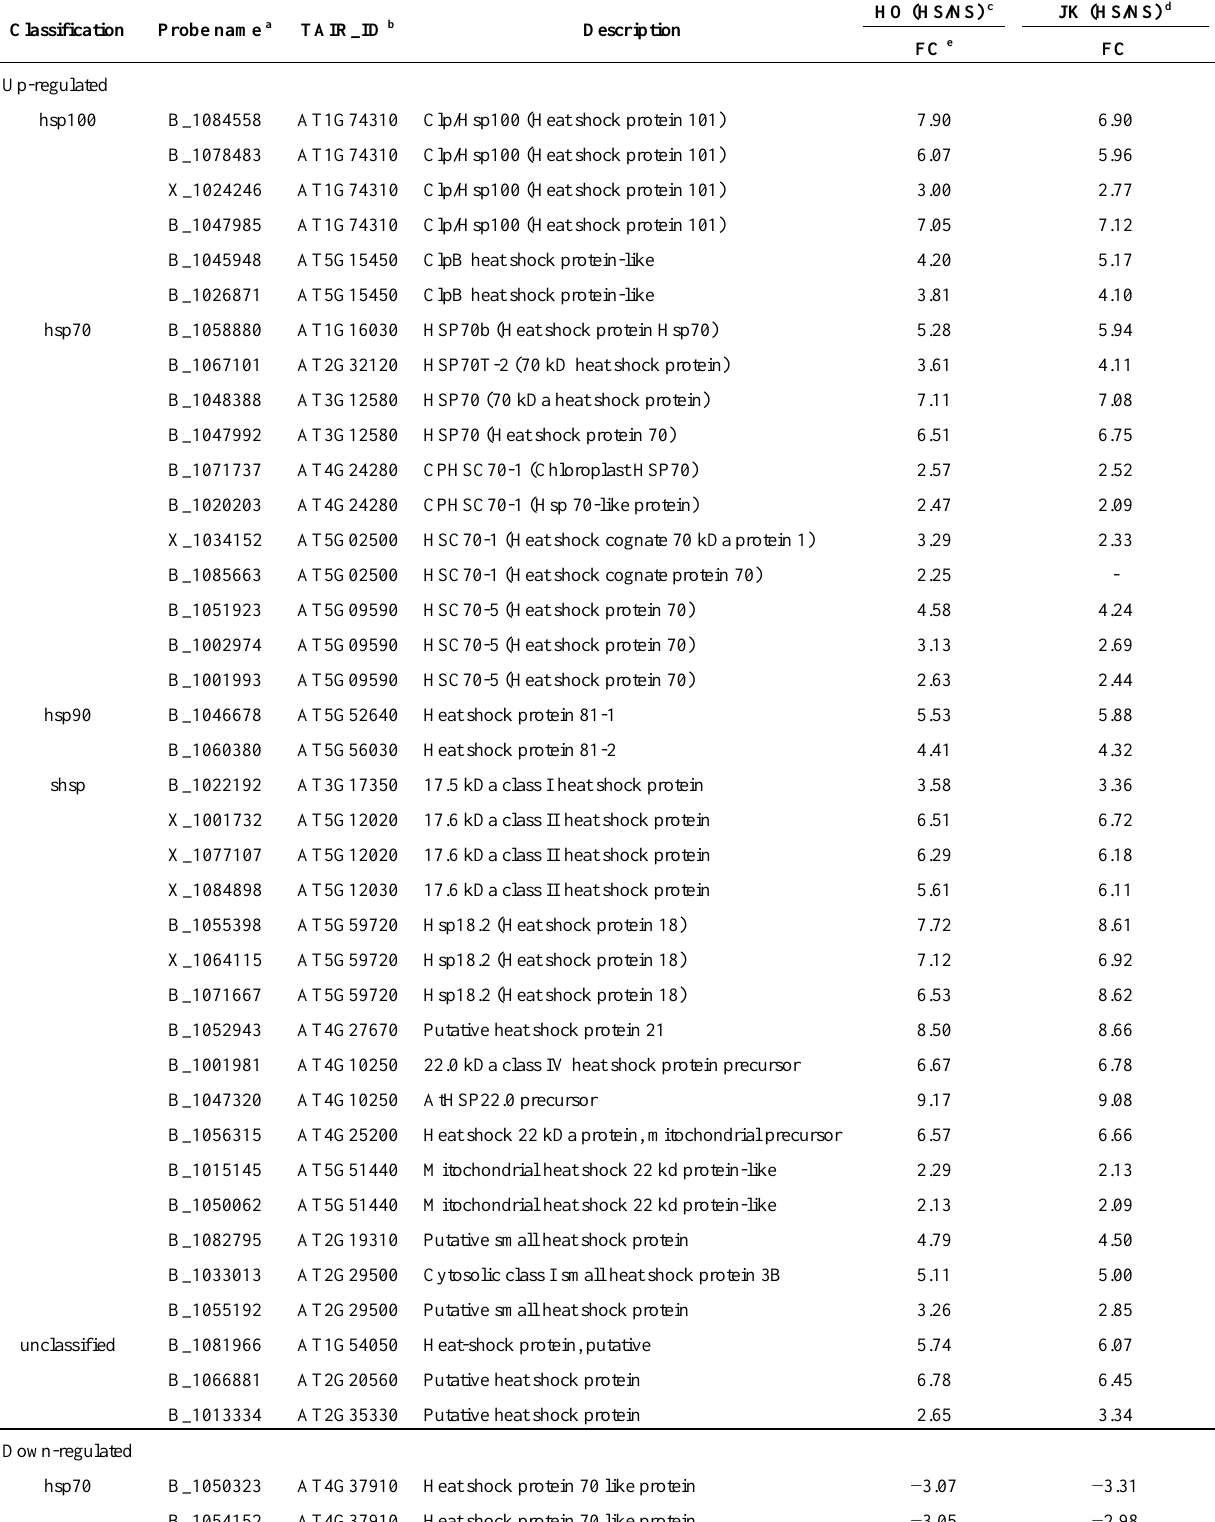
Table 1. Differentially expressed heat shock protein genes under heat stress in inbred line HO and